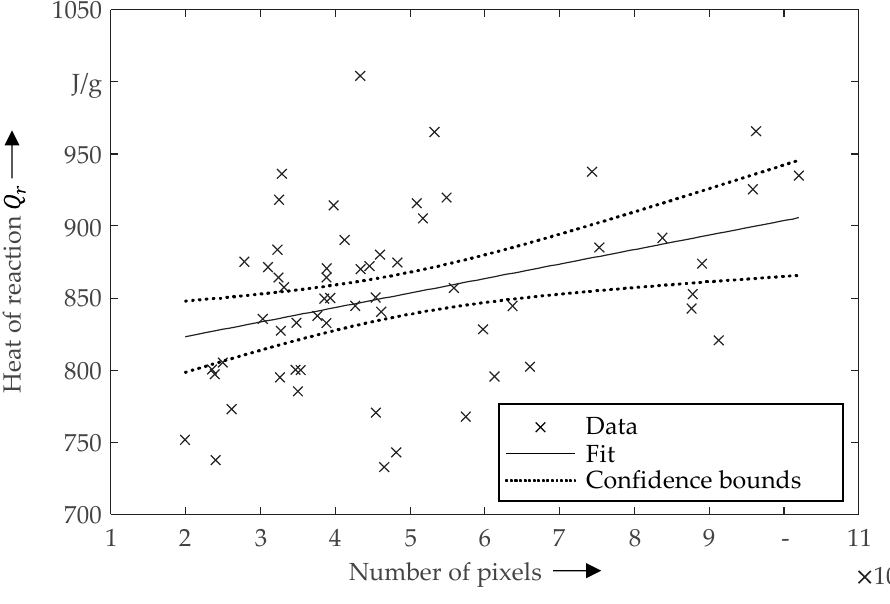
Figure 8. Linear regression model for the heat of reaction as a function of the NOP.